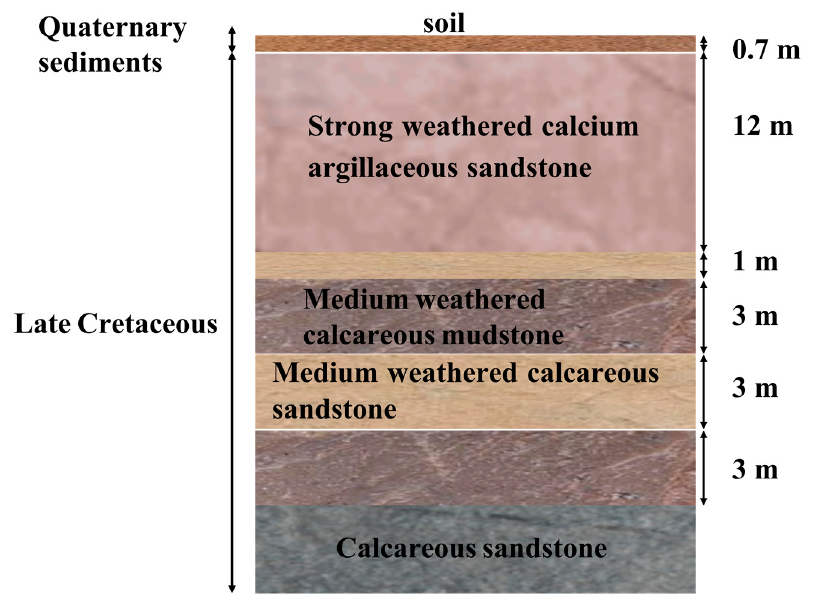
Figure 4. The stratigraphic lithology division.